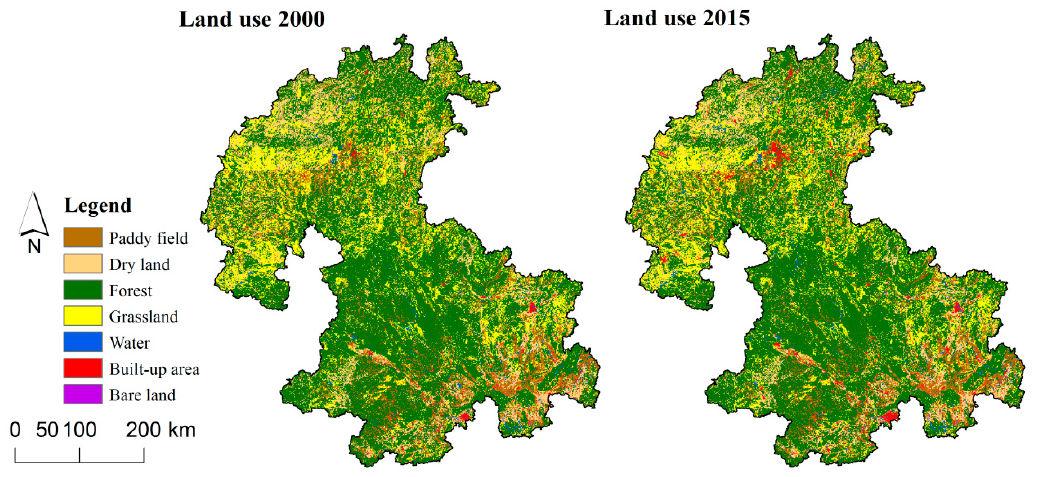
Figure 3. Land use map in 2000 and 2015.